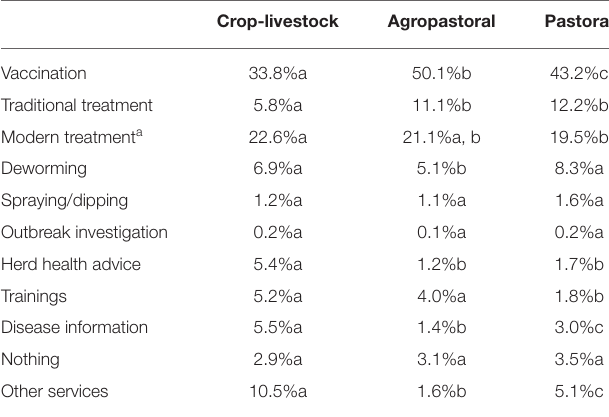
TABLE 3 | Percentage of respondents reporting the primary health services provided within pastoral, agropastoral and mixed crop-livestock systems in